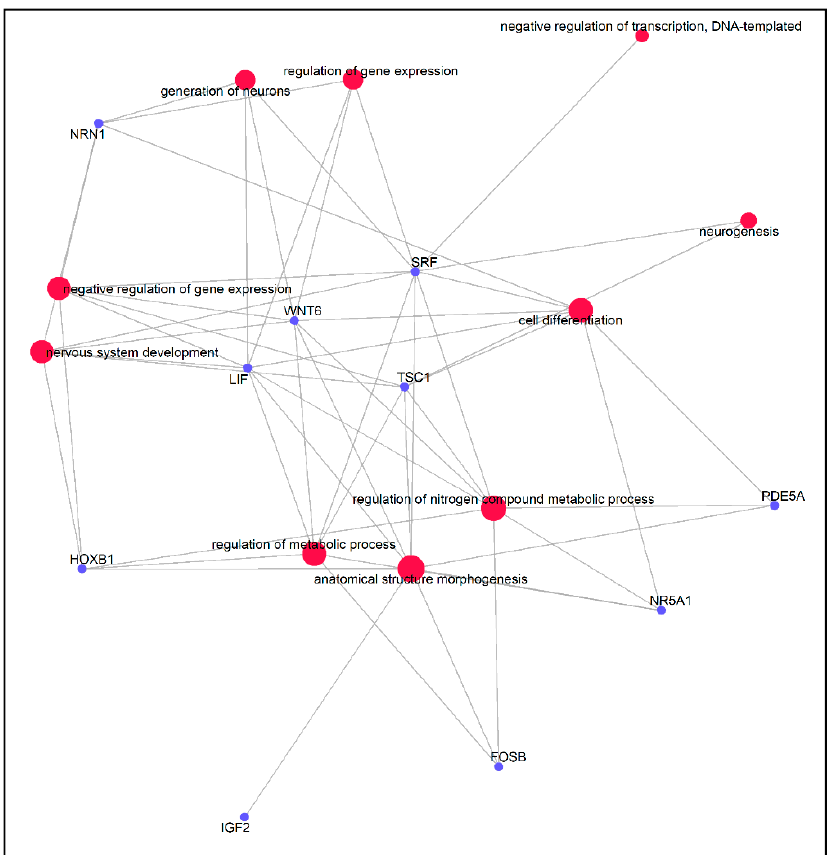
Figure 6. Gene-pathway association network indicating genes affiliated to significantly GO enriched pathways. Red dots indicate GO pathways and blue dots indicate genes.